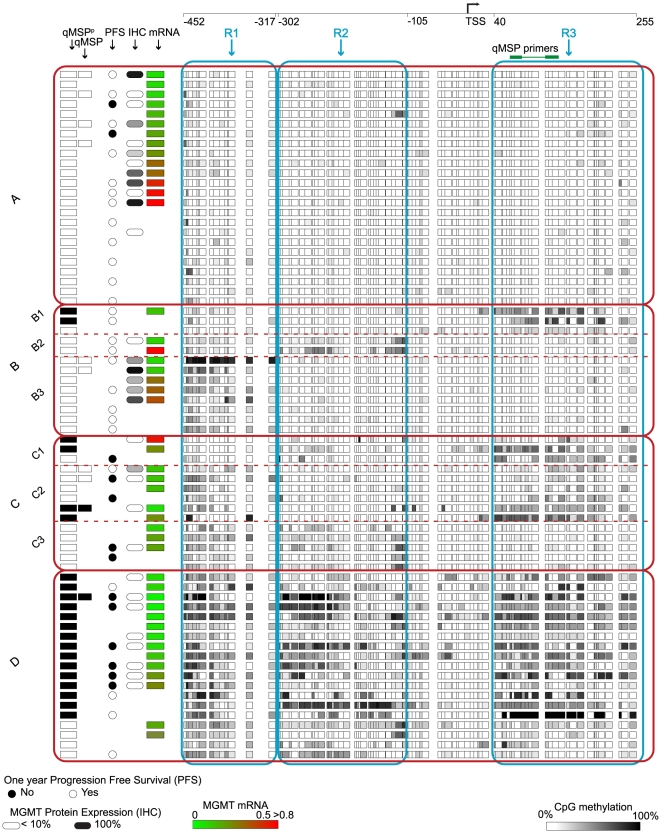
MGMT methylation profiles of 70 GBM samples show four distinct groups.Each row represents an individual patient. For each patient the qMSPP positive result is shown as a black rectangle. The next column shows the results of the qMSP test (Labcorp). PFS is represented by a circle with a blackened circle representing greater than 1 year PFS. Positive MGMT protein expression (>15% tumor cells stained positive in IHC) is shown as black rounded rectangle and negative expression is shown as white rounded rectangle. MGMT mRNA expression is shown using color-coded rectangles. Absence of any of the shapes indicates results not available. All CpG sites belonging to the three regions, R1, R2 and R3 are shown within the blue outlined squares. The four distinct groups are outlined with red squares. The qMSP region is labeled with qMSP primers in R3. The transcription start site (TSS) of the MGMT gene is marked by an arrow.